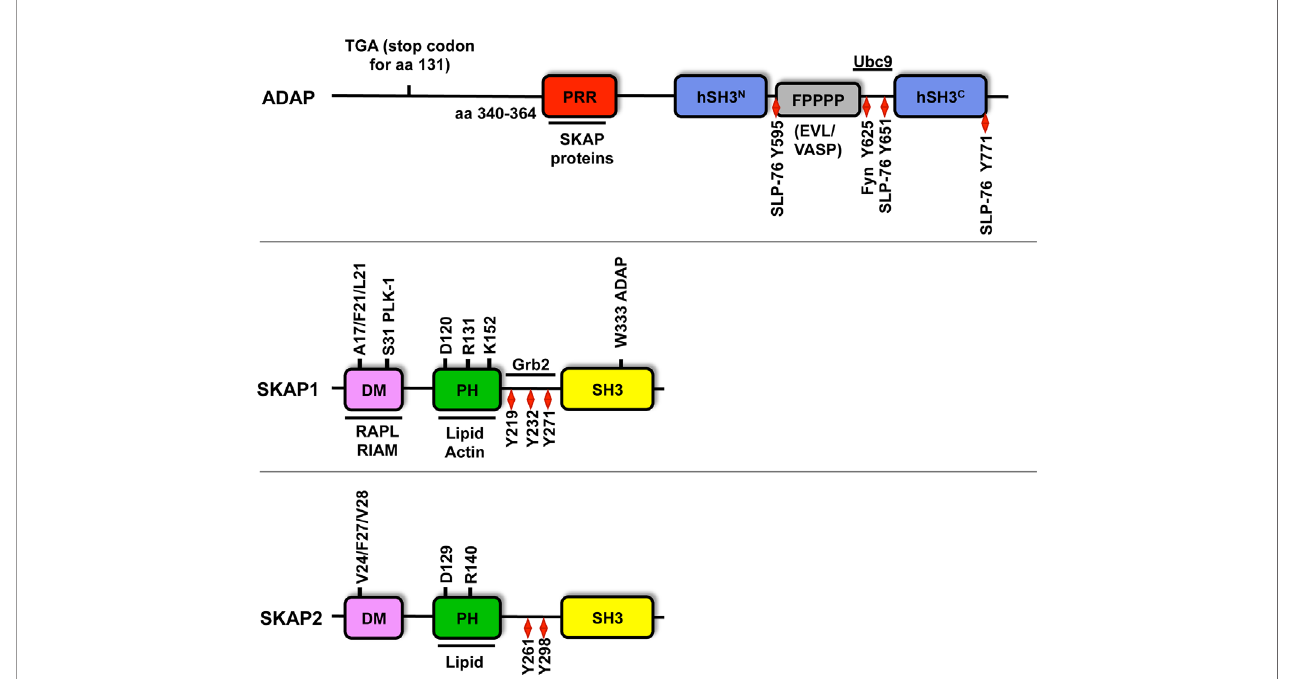
FIGURE 2 | Structure of ADAP, SKAP1 and SKAP2. Amino acid (aa) numbering is given for human ADAP (short isoform NP_955367.1), SKAP1 (NP_003717.3) and SKAP2 (NP_003921). ADAP possesses an unstructured N-terminal region (containing the predicted stop codon at position 131 of CARST patients with a Fyb gene defect), a proline rich region (PRR), two helical SH3 domains (hSH3), an Evl/VASP binding site (FPPPP), a NLS motif (binding site for Ubc9) and multiple tyrosine motifs (Y). Amino acid 340-364 of the PRR of ADAP binds to W333 within the C-terminus Src homology domain (SH3) of SKAP1. Both SKAP proteins possess a dimerization domain (DM), a Pleckstrin homology domain (PH) and a SH3 domain. SKAP1 contains three tyrosine motifs (red diamond), but SKAP2 possess only two of these motifs. Both SKAP proteins contain three amino acids at position V24/F27/V28 for SKAP2 or A17/F20/L21 for SKAP1 in the DM domain, which are important for dimerization. The amino acids R131/140 and K152 within the PH domain contribute to lipid and actin binding and are required for plasma membrane targeting. The amino acids D120/129 are critical residues for the DM-PH auto-inhibition model (see Figure 3 ). The S31 in the dimerization domain is involved in cell cycle regulation via PLK-1 binding. Other binding partners of individual amino acids and domains are